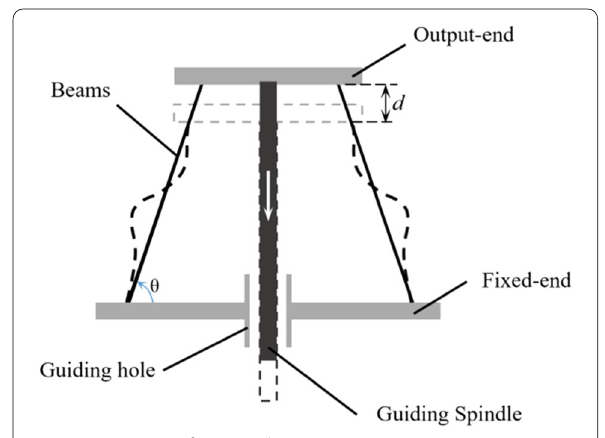
Figure 2 Constant-force